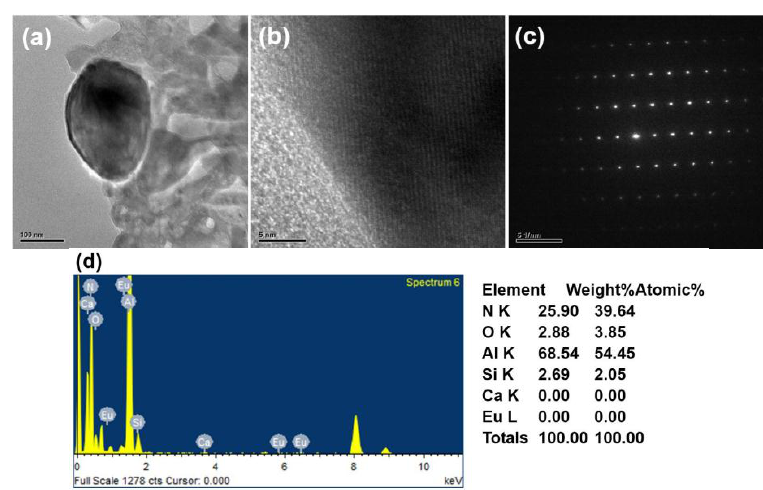
Figure 6. ( a ) TEM image; ( b ) HRTEM image; ( c ) SAED pattern; and ( d ) element analysis of a plate-like particle (showing it to be AlN) in a product synthesized with Ca:Al:Si:Si 3 N 4 :Eu 2 O 3 :NaN 3 :NH 4 Cl = 0.75:1.0:0.25:0.25:0.02:3.5:0.6.